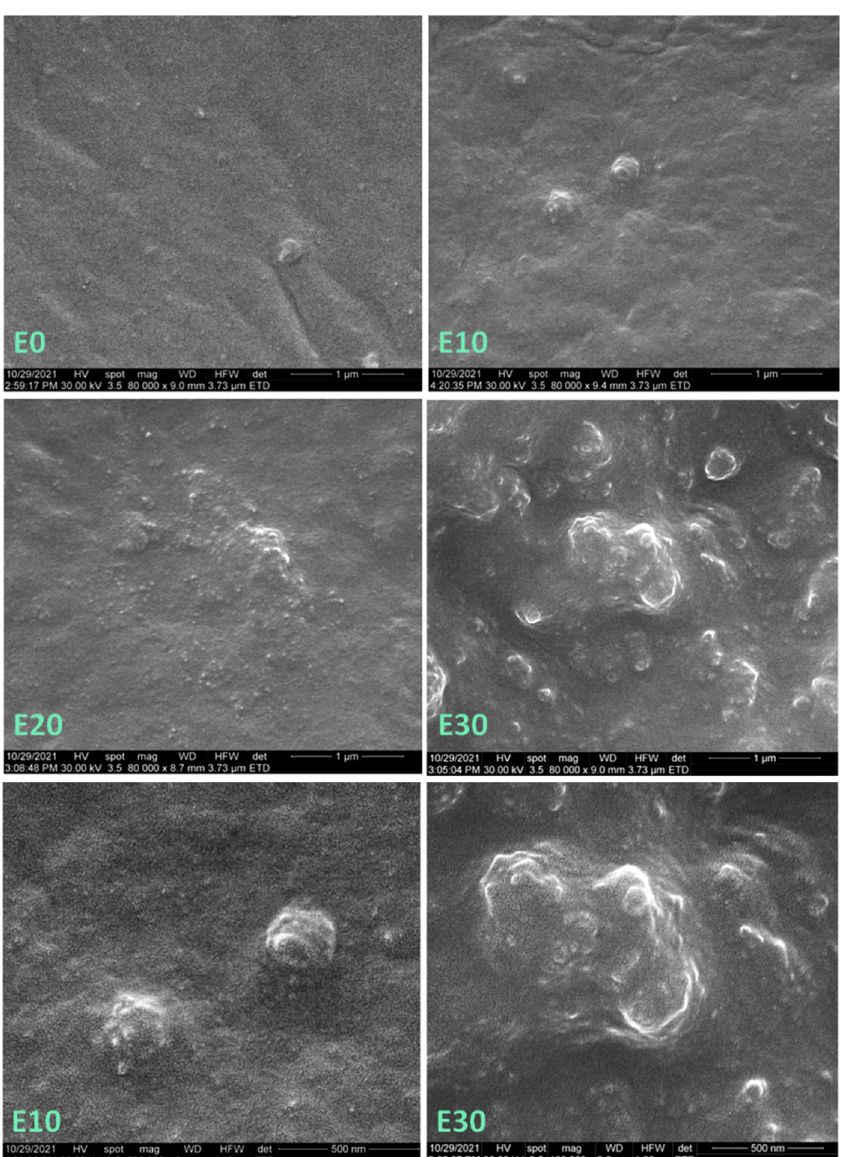
Figure 1. SEM images on the surface of E0, E10, E20, and E30 at ×80,000 magnification (top and center); higher magnification SEM images of E10 (×200,000) and E30 (×160,000) (bottom) . center); higher magnification SEM images of E10 ( × 200,000) and E30 ( × 160,000)